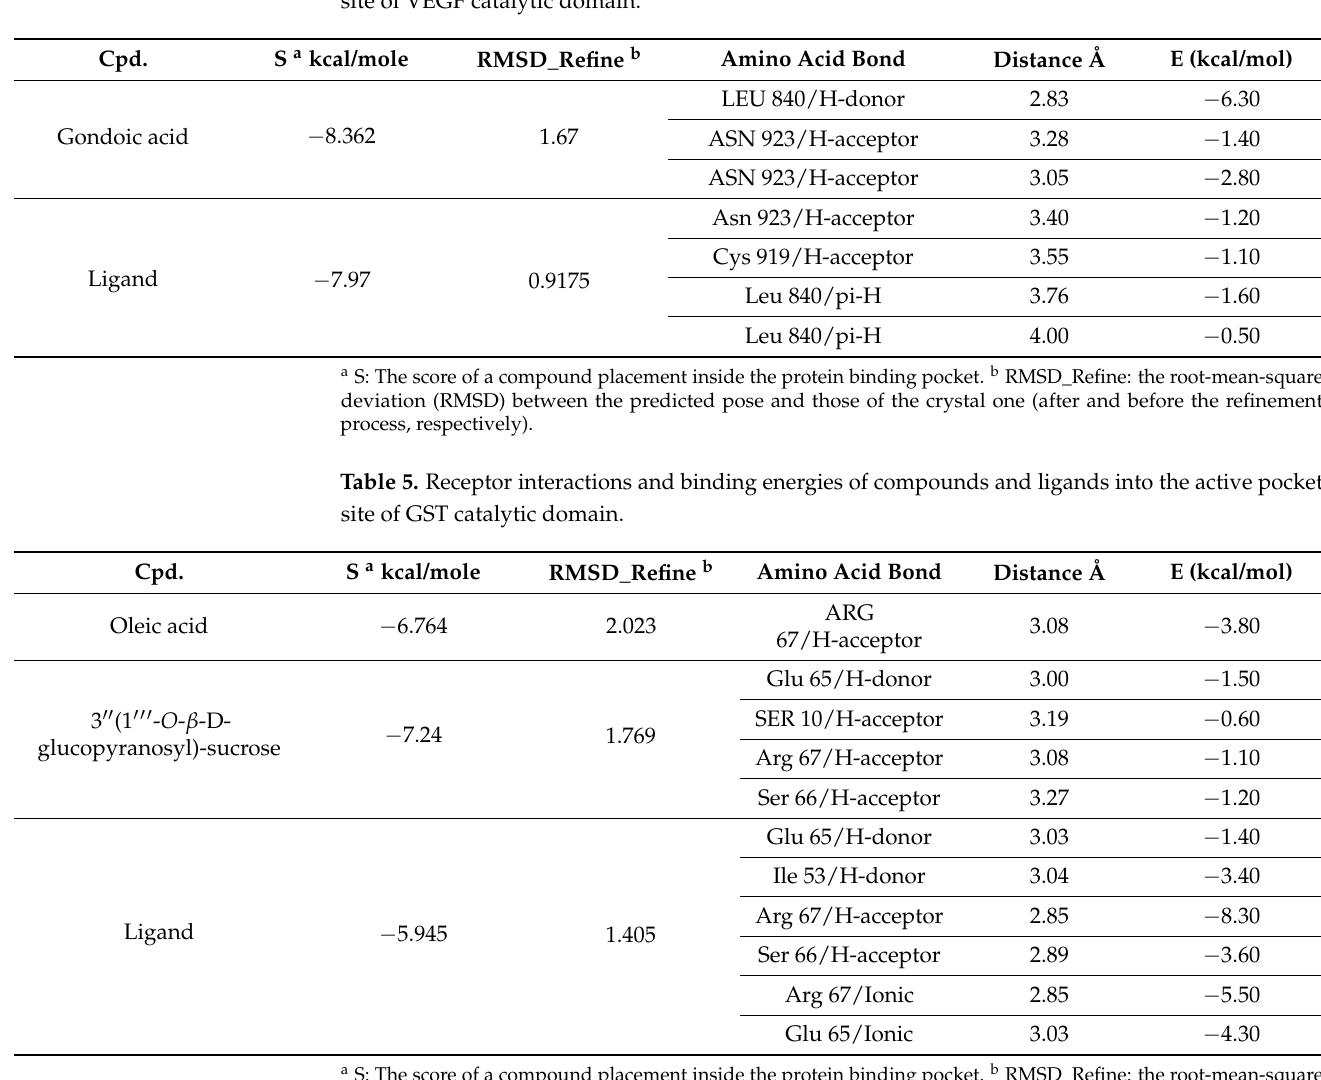
Table 4. Receptor interactions and binding energies of gondoic acid and ligand into the active pocket site of VEGF catalytic domain.